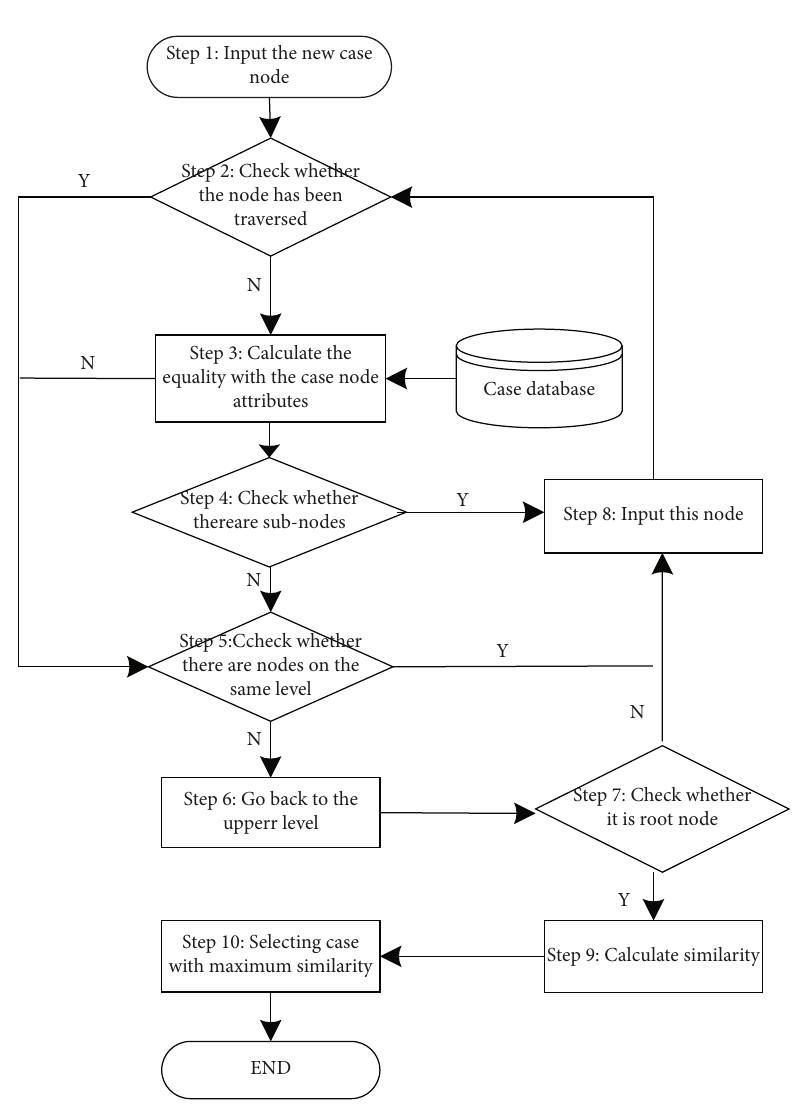
Figure 5: Similar case search comparison